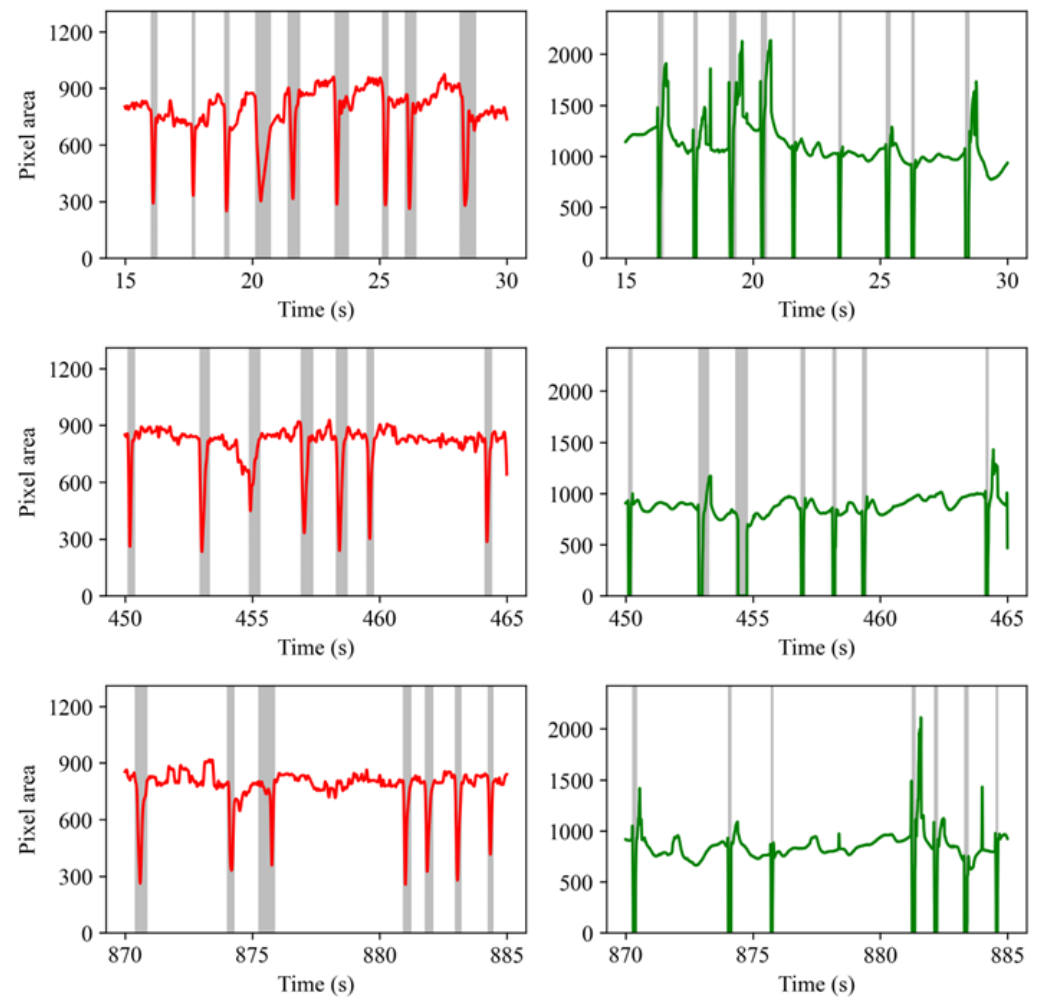
Figure 8. The eye blinks detected from the glass ( left panel ) and EyeLink ( right panel ) data recorded from Subject #2. Red lines represent the eye area data from our glasses; Green lines represent the pupil area data from the EyeLink eye-tracker. The detected blinks are marked with gray